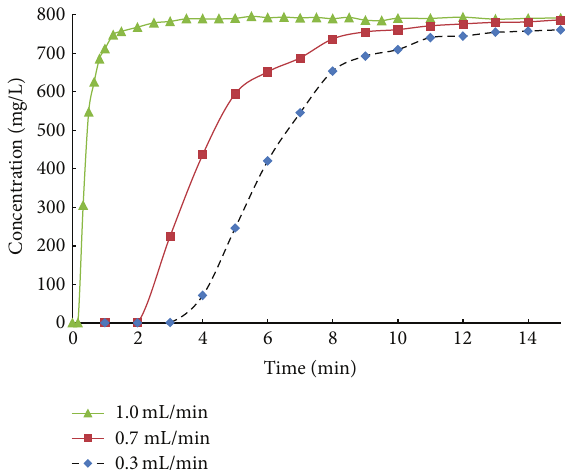
Figure 10: Effect of flow rate on adsorption of CO 2 onto fly ash. Reaction conditions: initial CO 2 concentration of 795 ppm, 1.5g ash, 20% RH, and 22 ∘ C.